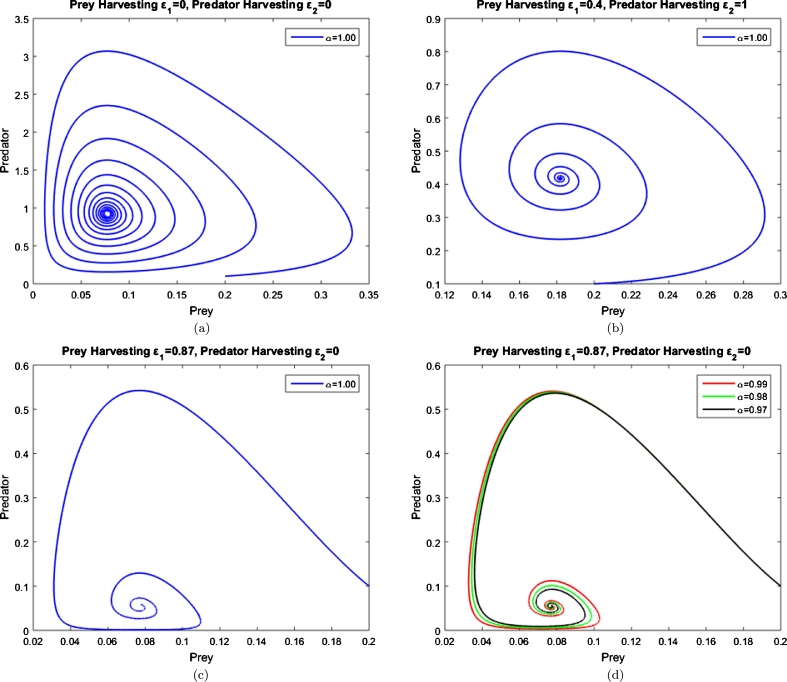
The impact of harvesting upon the system (4) with fractional order (0 < α ≤ 1), ρ = 1,ψ = 15,ϕ = 2 and (x(0),y(0))=(0.2,0.1).